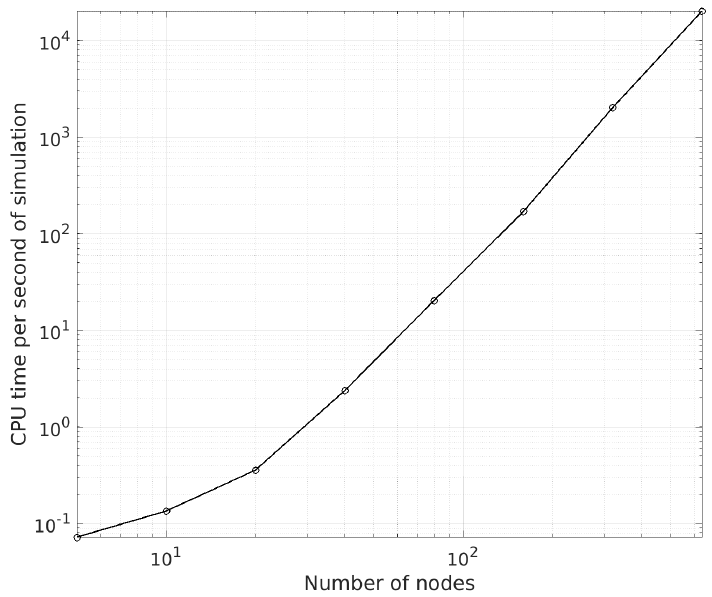
Figure 14. Dependence of the computational cost with the number of nodes for Koh experiment simulation. The slope on the logarithmic scale was found to be